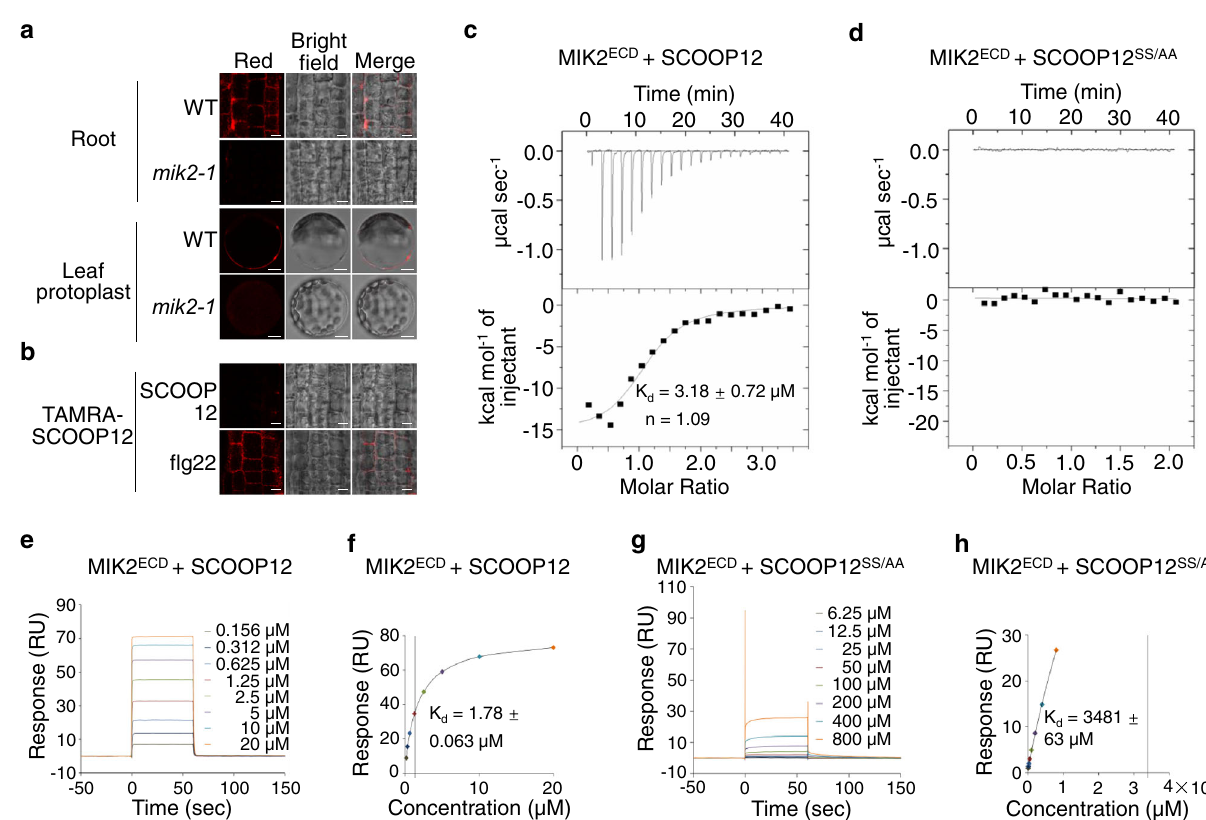
Fig. 4 SCOOP12 binds to MIK2. a TAMRA-SCOOP12 peptides label roots and protoplasts from WT but not mik2-1 . Confocal images of roots or protoplasts of WT and mik2-1 incubated with 100 nM TAMRA-SCOOP12 (see “ Methods ” for details). Scale bar, 4 mm (top), 10 µ m (bottom). b SCOOP12 but not fl g22 peptides compete for the binding of TAMRA-SCOOP12 to roots. Confocal images of roots of WT seedlings incubated with 100 nM TAMRA-SCOOP12 in the presence of 1 µ M SCOOP12 or fl g22 peptides. Scale bar, 4 mm. c , d SCOOP12 but not SCOOP12 SS/AA binds to MIK2 ECD with ITC assays. SCOOP12 ( c ) or SCOOP12 SS/AA ( d ) was titrated into a solution containing MIK2 ECD in ITC cells (see “ Methods ” for details). The top panels show raw data curves, and the bottom panels show the fi tted integrated ITC data curve. The calculated binding kinetic dissociation constant ( K d values ± fi tting errors) for SCOOP12 with MIK2 ECD is 3.18 ± 0.72 µ M, and the stoichiometry of binding (n) is approximately equal to one ligand molecule per receptor molecule ( c ). No binding was detected for SCOOP12 SS/AA with MIK2 ECD ( d ). e , f SCOOP12 binds to MIK2 ECD with SPR assays. MIK2 ECD proteins were immobilized on a sensor chip, and SCOOP12 peptides were used as fl ow-through analyte for SPR assays (see “ Methods ” for details). e The SPR sensorgram pro fi le of SCOOP12 peptides at gradient concentrations fl owing through the MIK2 ECD immobilized chip. f The steady-state af fi nity (binding at equilibrium) indicated by a calculated K d of 1.78 µ M. g , h SCOOP12 SS/AA does not bind to MIK2 ECD with SPR assays. Similar assays using SCOOP12 SS/AA peptides were performed as in ( e ) and ( f ). The SPR sensorgram pro fi le ( g ) indicates nearly no binding between MIK2 ECD and SCOOP12 SS/AA with a K d of 3481 µ M ( h ). The above experiments were repeated twice with similar performed a gel fi ltration assay of BAK1 ECD and MIK2 ECD puri fi ed from insect cells in the presence of SCOOP12 or SCOOP12 SS/AA peptides. The results show that MIK2 ECD and BAK1 ECD proteins co-migrated in the presence of SCOOP12 (Fig. 5g, h), indicating that SCOOP12 induces the dimerization of MIK2 ECD and BAK1 ECD . The protein complex was eluted mainly at the position corresponding to a size of a monomeric MIK2 ECD -BAK1 ECD (~120 kDa) (Fig. 5g, h), suggesting that SCOOP12 may not induce the homodimerization of the MIK2 ECD -BAK1 ECD complex. In